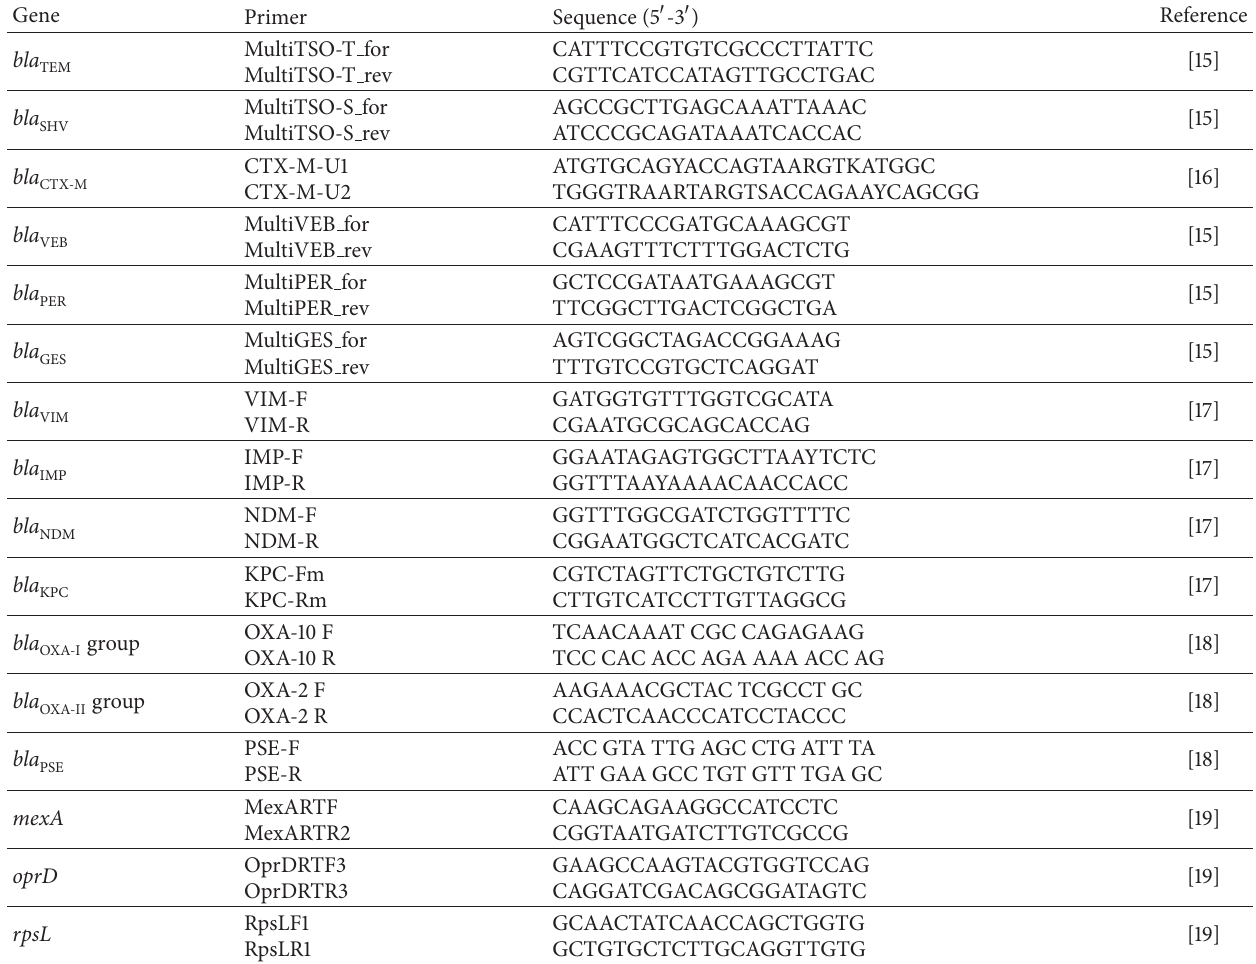
Table 1: Primers used in this